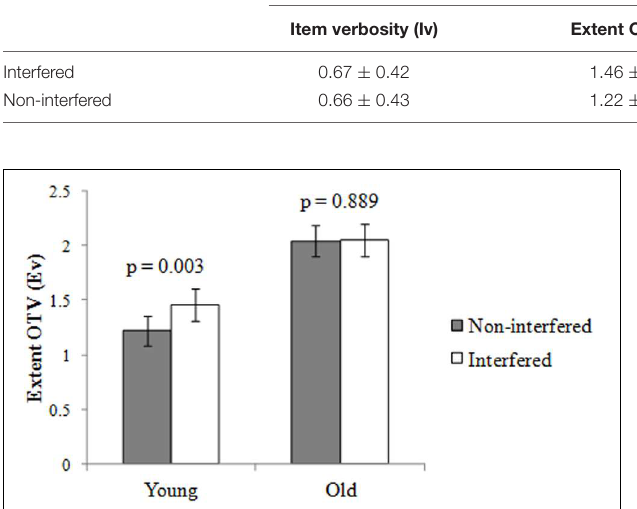
FIGURE 2 | The role of access function in the age-related off-topic verbosity (OTV): The interaction between age and interference condition on the extent of OTV in Experiment 1. It shows the mean extent of OTV scores for the individuals. Error bars represent standard errors of the